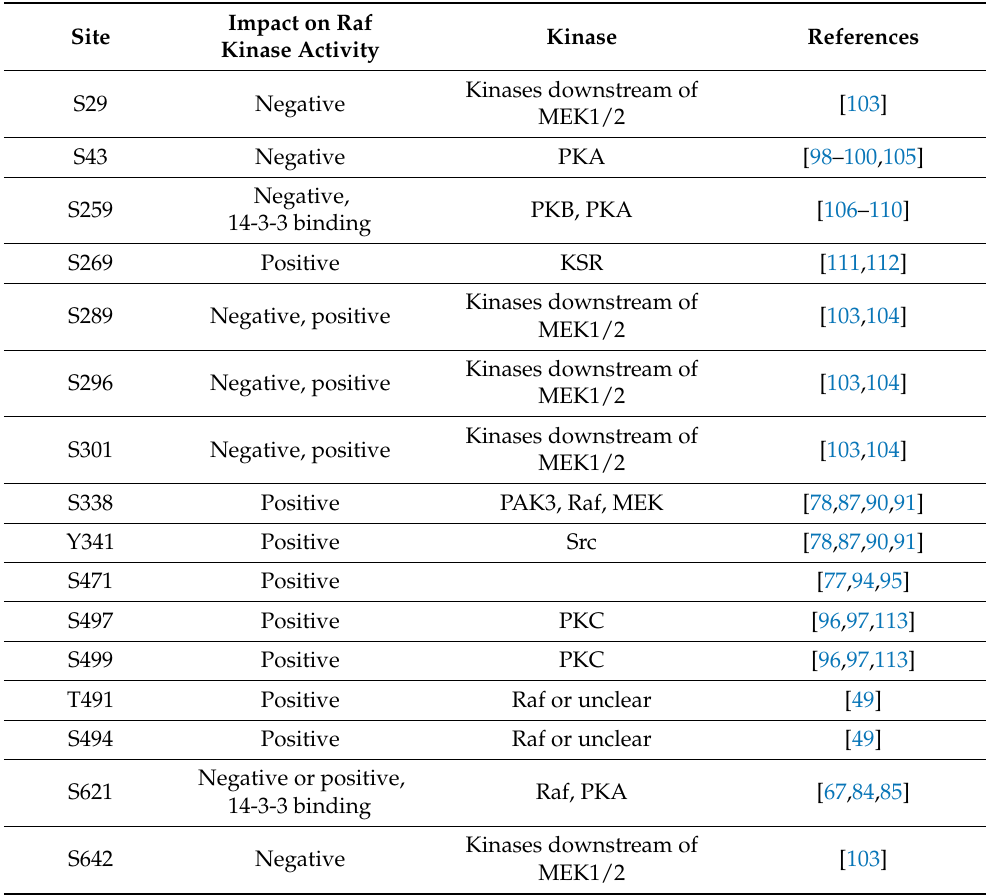
Table 1. Impact of phosphorylation on C-Raf kinase activity.